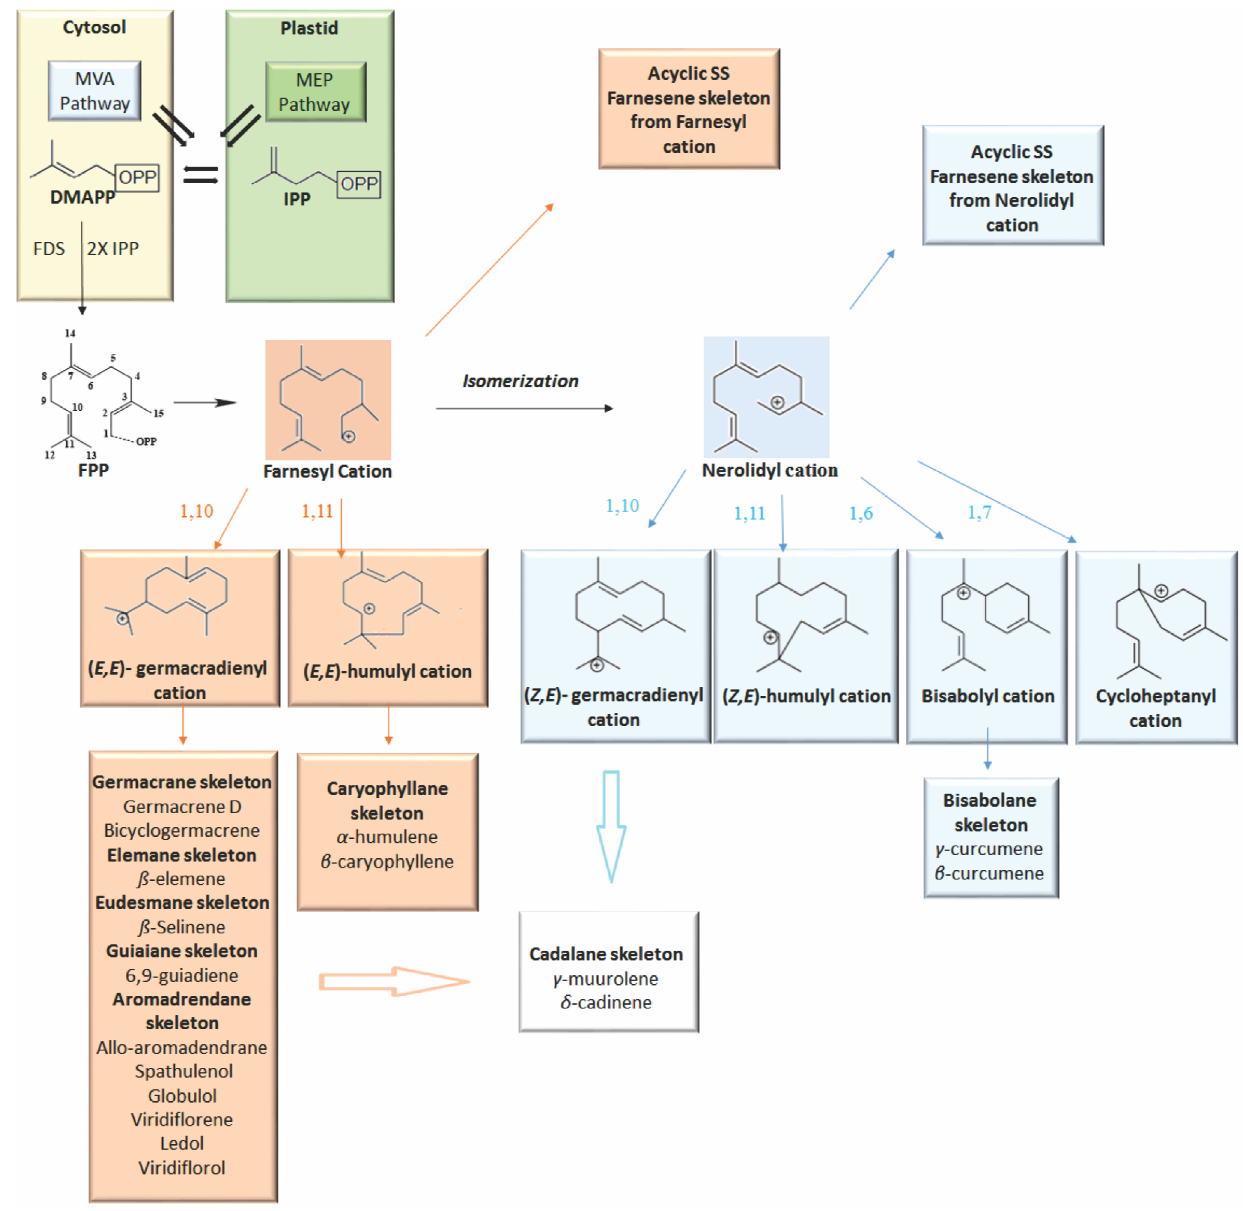
Figure 1. Biosynthesis of sesquiterpenes in Vitex species. Sesquiterpeneshavemorethan7000identifiedcarbonskeletonsfromdifferentorganisms